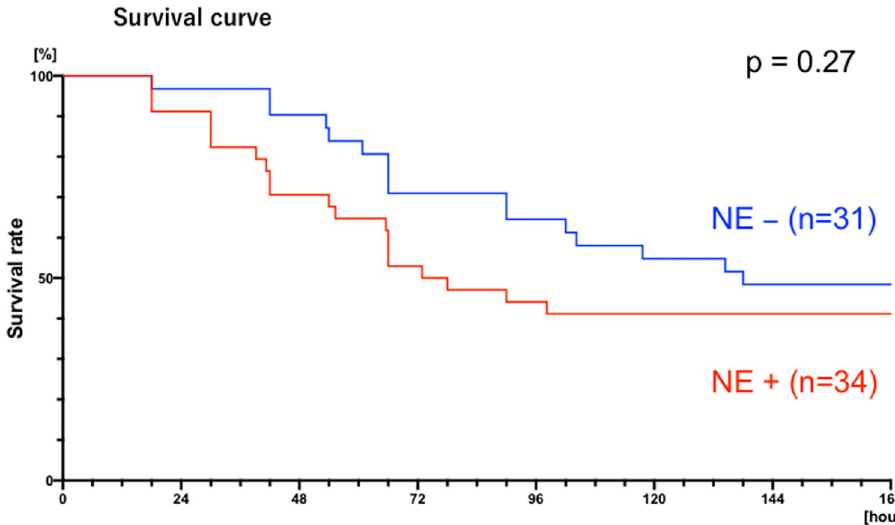
Fig 4. Kaplan-Meier survival curve of norepinephrine (NE)-treated mice (red; n = 34) compared with vehicle- treated mice (blue; n = 31).